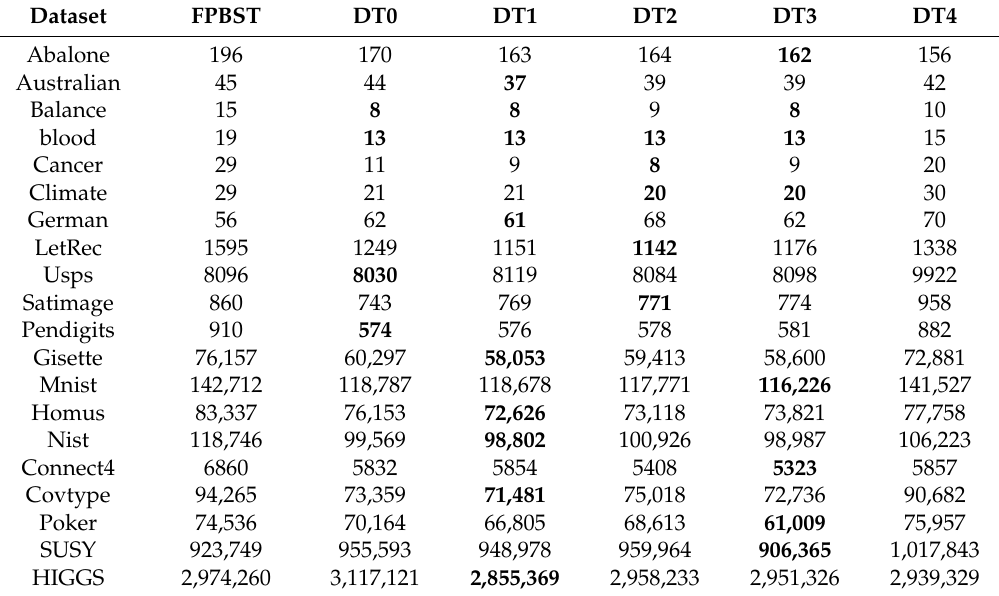
Table 5. Time (ms) consumed by the proposed methods DT0–DT4 to build their DTs compared to that of the FPBST to build its BST, this is the average training time of the 10